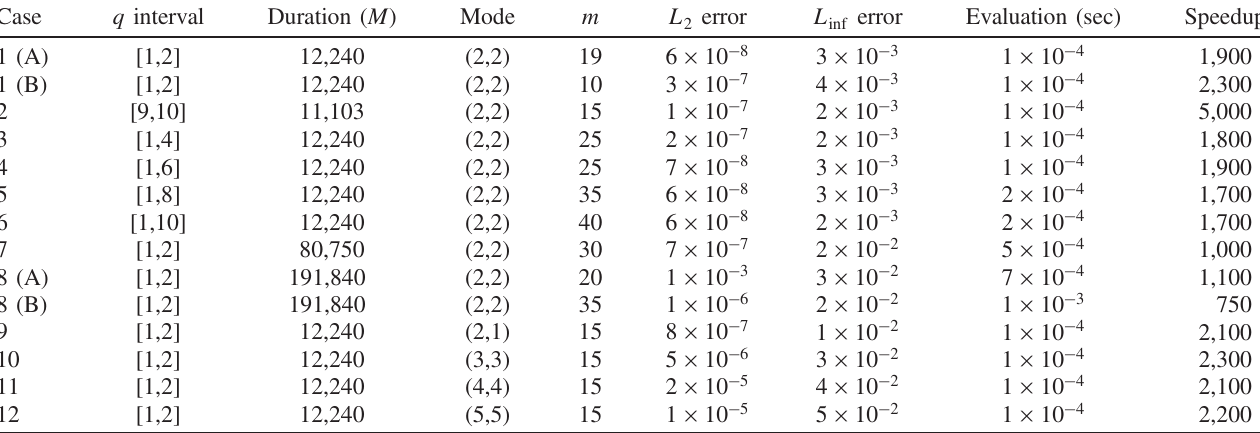
TABLE I. Errors, evaluation times, and speedups of surrogate models for various intervals of mass ratios, durations in time (i.e., number of cycles), and spin-weighted spherical harmonic